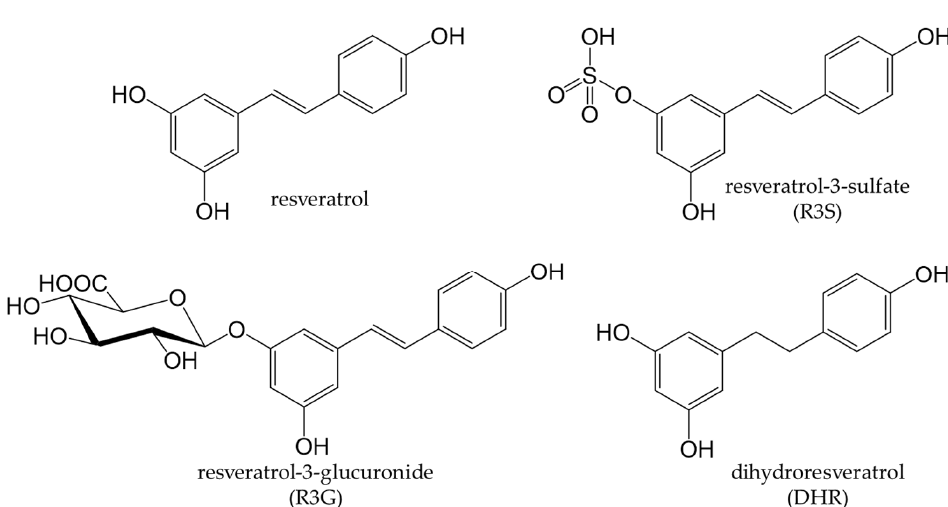
Figure 13. Chemical structures of major stilbenoids.